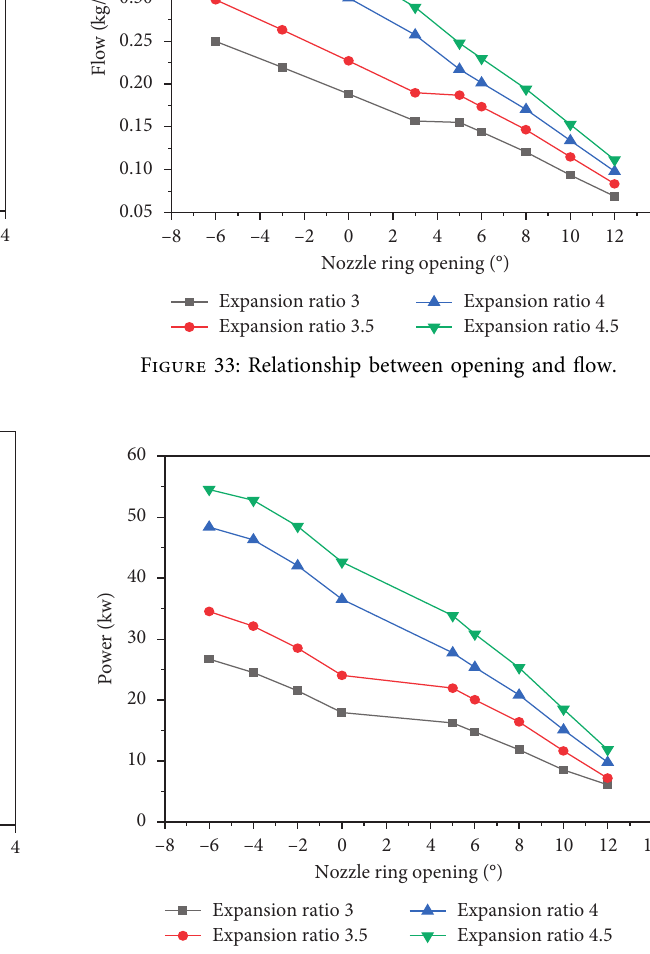
Figure 34: Relationship between opening and power.